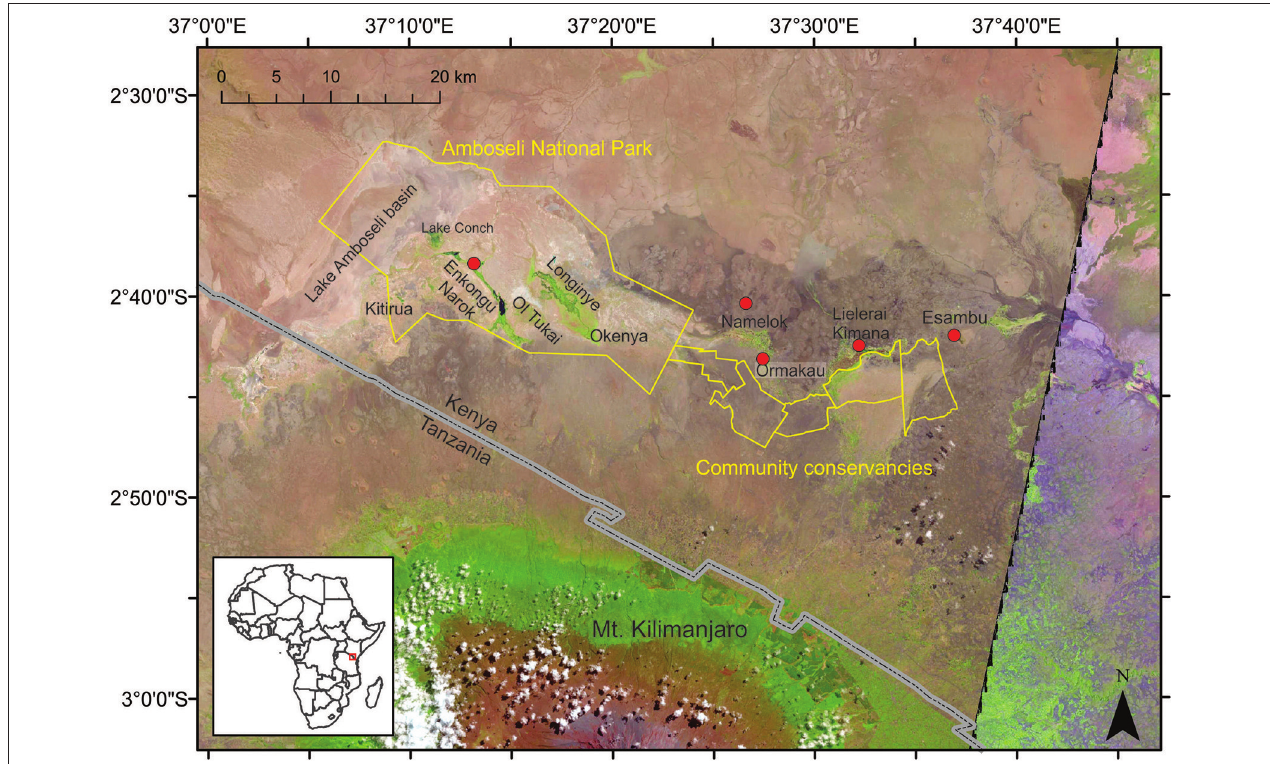
FIGURE 1 | Location of the study region in Africa map (bottom left inset). Esambu, Kimana, Ormakau, Namelok, and Enkongu coring sites (red dots) and the community conservancies (yellow delimitations) that create a corridor through the wetlands westward toward Amboseli National Park (main map). Base Landsat images LC81680622014194LGN00 (left side and inset) LC81670622015014LGN00 (right